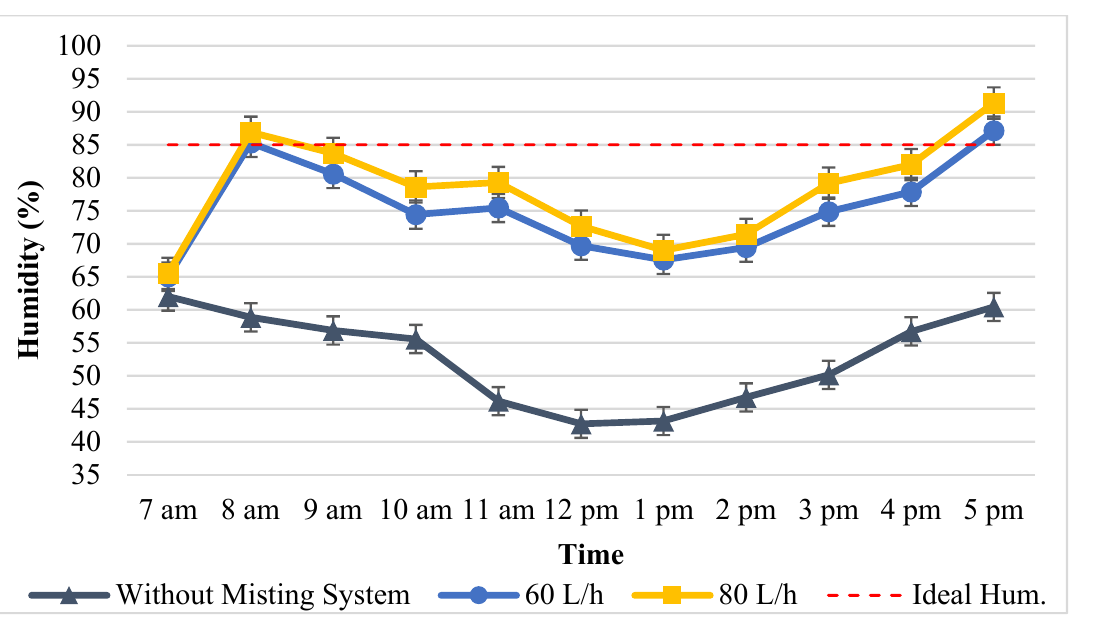
Figure 5. Greenhouse temperature with the misting system mass flow rate of “80 L/h” and “60 L/h”.